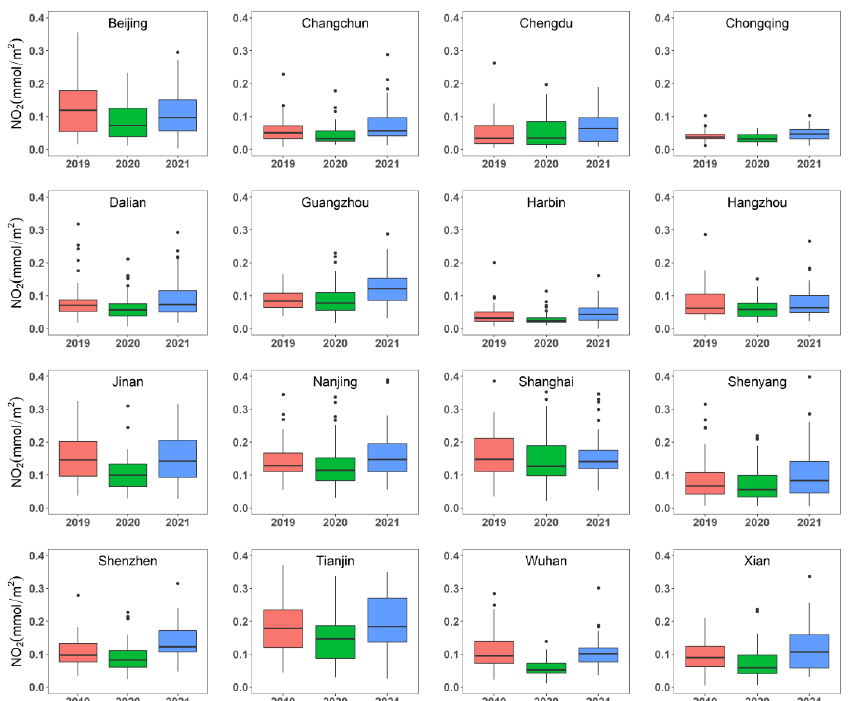
Figure 2. Box plot of NO 2 concentrations in the study periods for the years 2019, 2020, and 2021.The box represents the inter-quartile range (IQR) and the average value (i.e., the line inside). The two whiskers show (Q3 + 1.5 × IQR) or the maximum value and (Q1 − 1.5 × IQR) or the minimum value, respectively.